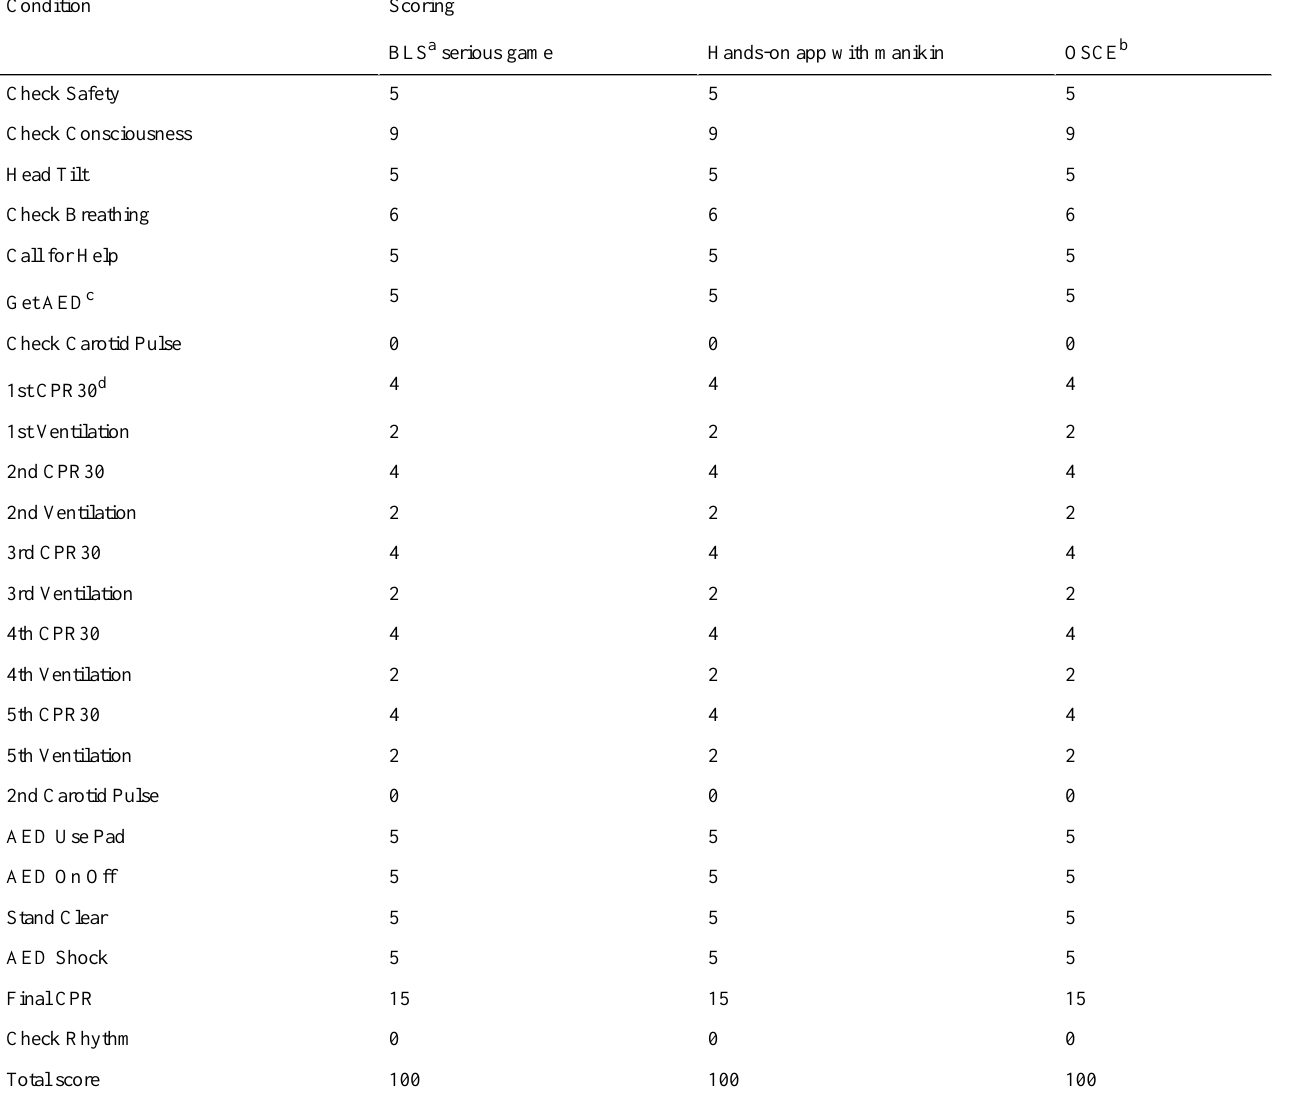
Table 1. Score comparisons according to